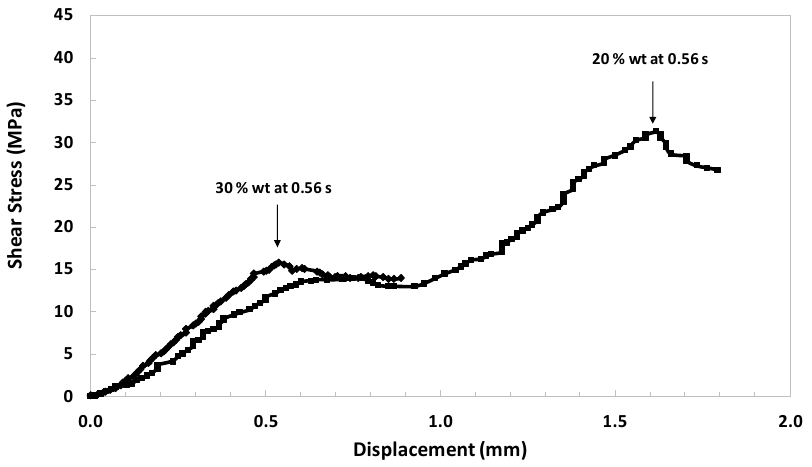
Figure 15. Shear stress–displacement curves for composites with prepreg fibre contents of 20 wt.% ( ■ ) and 30 wt.% ( ♦ ) with an initial exposure time of 0.56 s.